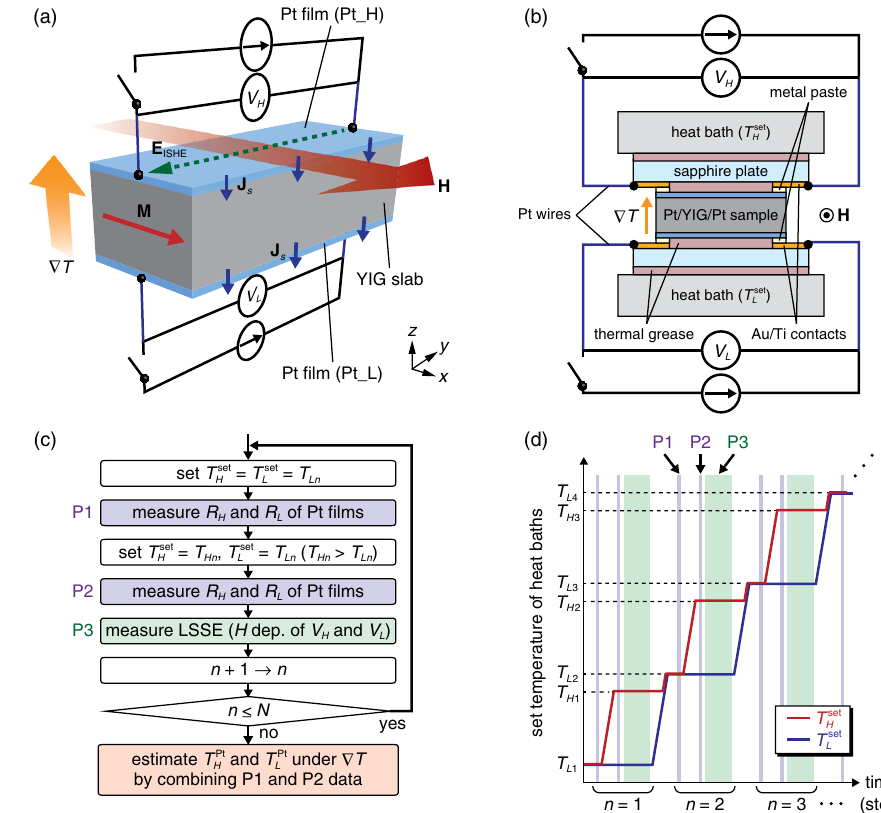
FIG. 1. (a) A schematic illustration of the Pt = YIG = Pt sample. ∇ T , H , M , E , and J s denote the temperature gradient, magnetic ISHE field (with the magnitude H ), magnetization vector, electric field induced by the ISHE, and spatial direction of the thermally generated spin current, respectively. The electric voltage V H ( V L ) and resistance R H ( R L ) between the ends of Pt_H (Pt_L) are measured using a nanovolt, micro-ohm meter (Agilent 34420A) in the “ dc-voltage ” and “ 2-wire-resistance ” modes, respectively. The dc-voltage (2-wire-resistance) mode corresponds to the switch-off (switch-on) state in this schematic illustration. (b) Experimental configuration for measuring the LSSE used in the present study. (c) Flow chart of the measurement processes. (d) Schematic graph of the set temperatures, T Hn and T Ln , of the heat baths as a function of time or the measurement step number n . Process P1 is performed under the isothermal condition, while processes P2 and P3 are under the temperature gradient. Before starting processes P1 and P2, we wait for ∼ 30 min at each n to stabilize the T set T set H and L